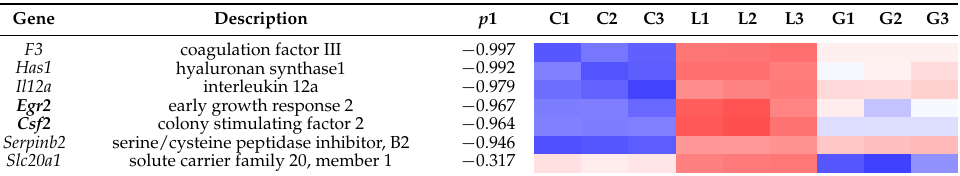
Table 2. Heat map of the genes highlighted in Figure 2B.